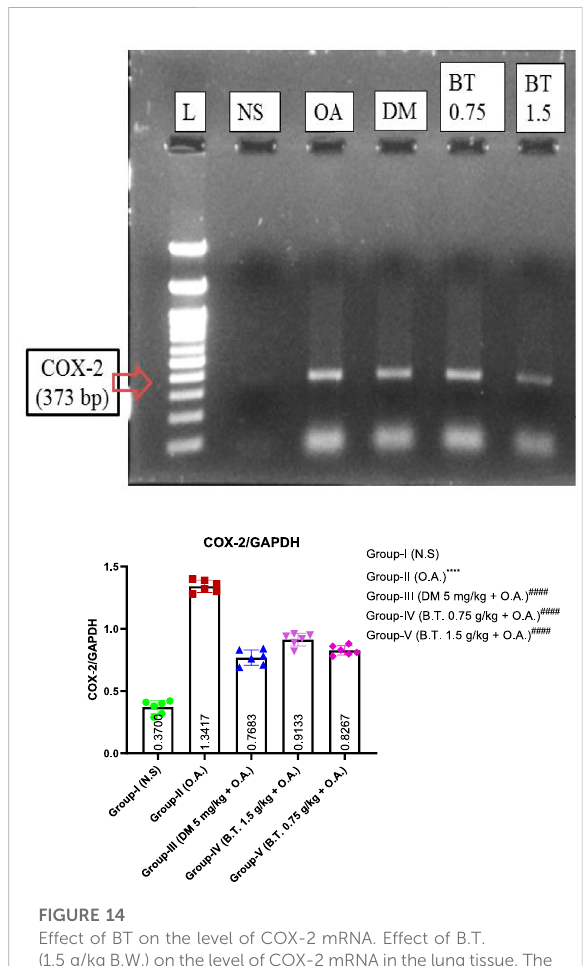
FIGURE 14 Effect of BT on the level of COX-2 mRNA. Effect of B.T. (1.5 g/kg B.W.) on the level of COX-2 mRNA in the lung tissue. The level of COX-2 was signi fi cantly increased in oleic acid treated group which was signi fi cantly reduced in B.T. (1.5 g/kg B.W.) pretreated group suggesting its protective action Comparisons between groupswereperformedusingone-way ANOVA (Turkey ’ s multiple comparison tests) to compare the mean values of each group with each other. ( *p < 0.05, ***p < 0.01, and ****p < 0.001 is signi fi cantly different from group I; ### p < 0.01 and #### p < 0.001 are signi fi cantly different from group